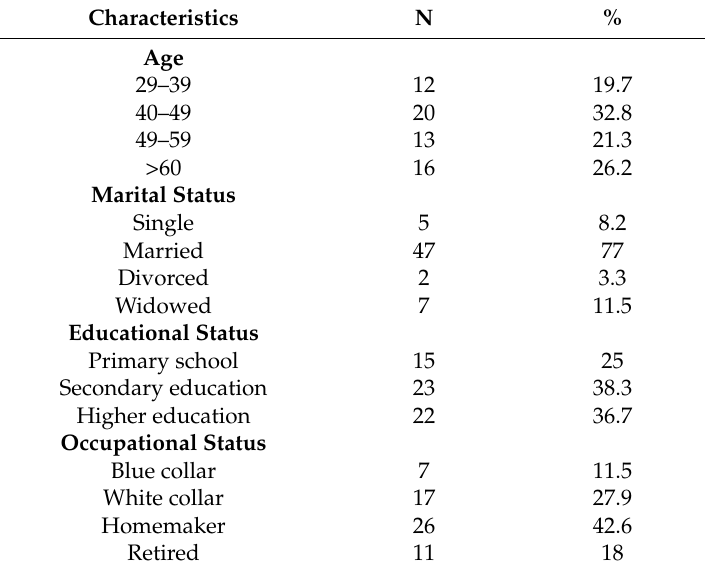
Table 1. Demographic characteristics of the sample.